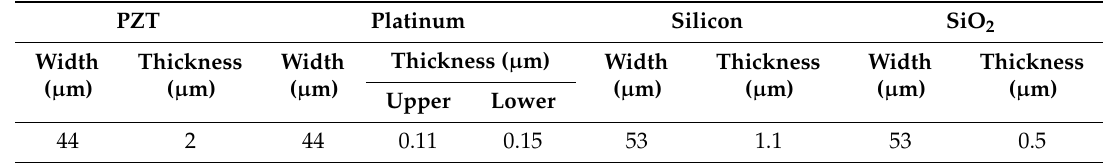
Table 2. Piezo-membrane